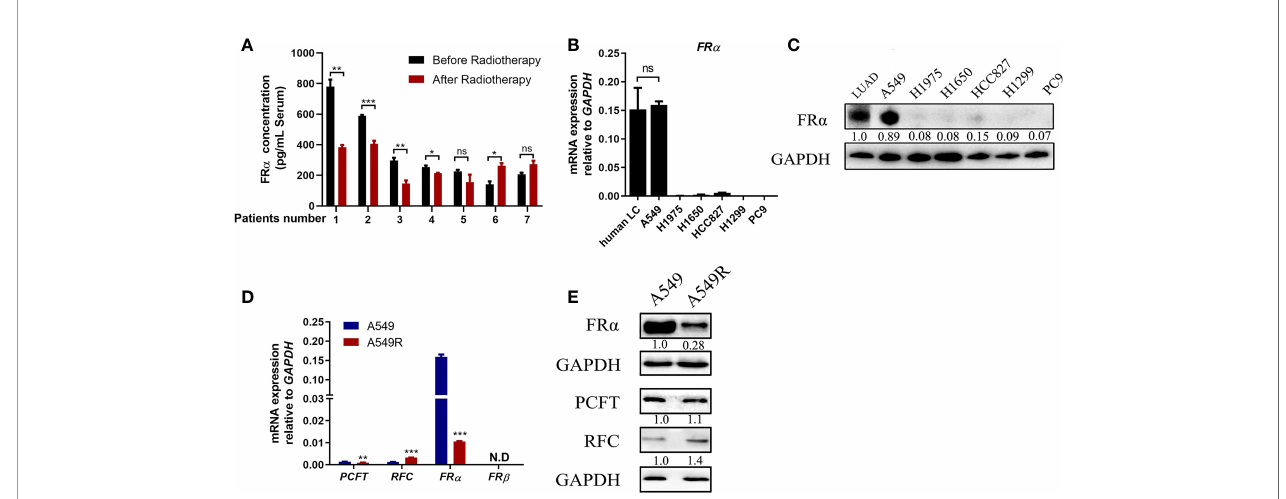
FIGURE 1 | Long-term fractionated radiotherapy downregulated the expression of FR a in A549 cells. (A) Serum FR a concentration in 7 patients with LUAD. (B) The FR a mRNA expression level in human LUAD tissues and LUAD cell lines. (C) Expression of the FR a protein in human LUAD tumors (5 human tumors were pooled) and cell lines. (D) The mRNA expression of pemetrexed-related transporters and receptors. PCFT and FR a were signi fi cantly downregulated in A549R cells compared with A549 cells. RFC was upregulated and FR b was not detected. (E) Expression of the FR a , PCFT and RFC proteins in A549 and A549R cells. Data are presented as the means ± SE, n =18 (human LUAD tissues) or 3 (cell lines or serum). Differences between A549 and A549R cells are denoted as *p < 0.05, **p < 0.01, and ***p < 0.001. ns, not signi fi cant. For immunoblots, densitometric values are shown as optical density after GAPDH normalization using Image